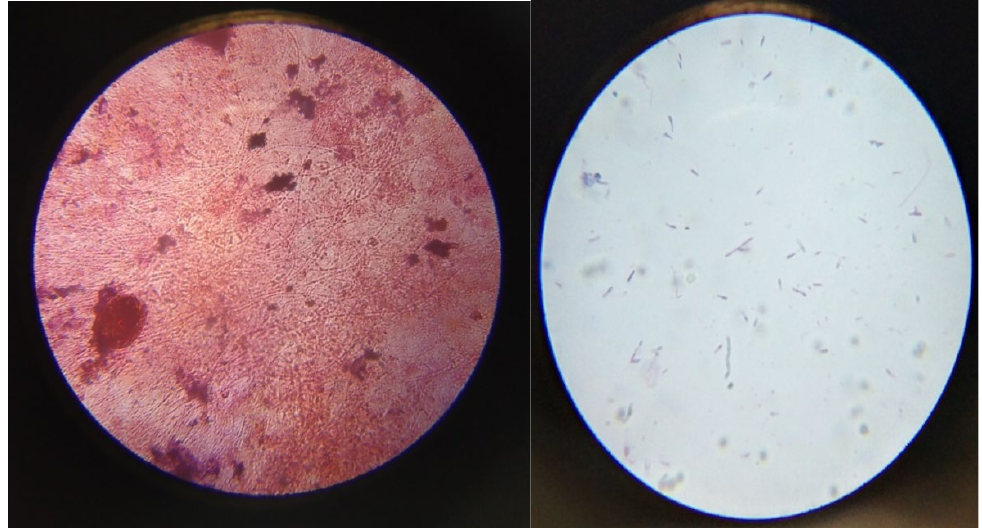
Fig. 18. Biofilm Slide without CuNPs and with CUNPs